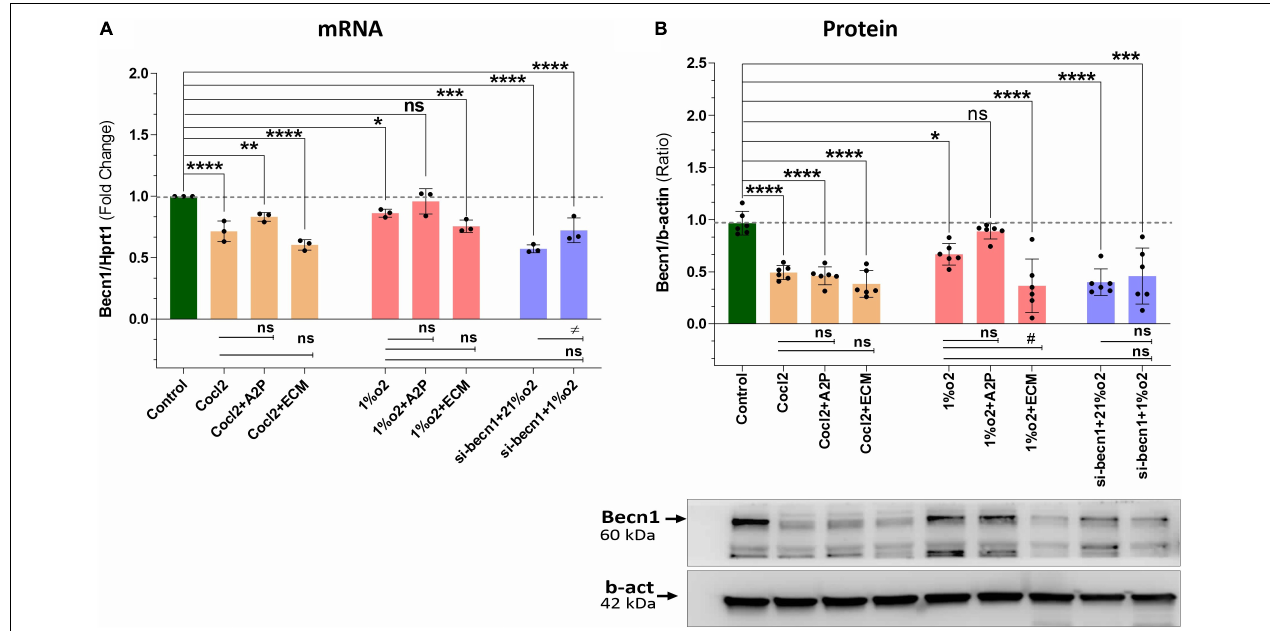
FIGURE 9 | Hypoxia, Cocl2 exposure decrease the Autophagy protein- Becn1 ( Beclin-1) expression at mRNA and Protein level. (A) Becn1 mRNA expression levels (B), Becn1 protein expression levels and representative western blots showing Becn1 protein levels in H9c2 cells treated with ECM, A2P, siRNA-Beclin1 and grown under CoCl2, Hypoxia (1%O2), and Normoxia conditions (21%O2). Becn1 mRNA levels was decreased in h9c2 cells exposed to Cocl2 (**** p < 0.0001), Cocl2 + ATP (** p < 0.004) and Cocl2 + ECM (**** p < 0.0001). Becn1 mRNA levels decreased in Hypoxia cells (1%O2) (* p < 0.019) and in Hypoxia (1%O2) + ECM, *** p < 0.0001. Beclin-1 inhibition decreased the becn1 mRNA levels in normoxia (21%O2) **** p < 0.0001 and in hypoxia (1%O2) (**** p < 0.0001) exposed cells. Becn1 protein expression levels also decreased in Cocl2 (**** p < 0.0001), Cocl2 + A2P (**** p < 0.0001), Cocl2 + ECM (**** p < 0.0001), and in Hypoxia (1%O2) * p < 0.026, and in 1%O2 + ECM (**** p < 0.0001). Beclin-1 inhibition confirms the decreased Becn1 protein under normoxia (21%O2) exposure (**** p < 0.0001) and in Hypoxia (*** p < 0.0003). Data represents, n = 3 (mRNA) and n = 6 (Protein) independent samples/group; Bars are mean ± S.D. Symbols * , + , # and (cid:54)= denotes significant, “ns” represents not significant by two-way ANOVA- multiple comparisons test. P-values are ns p > 0.05, * p < 0.05, ** p < 0.01, *** p < 0.001, and **** p < 0.0001 compared to Control; + p < 0.05, ++ p < 0.01, +++ p < 0.001, and ++++ p < 0.0001 compared to Cocl2; # p < 0.05, ## p < 0.01, ### p < 0.001, and #### p < 0.0001 compared to Hypoxia; (cid:54)= p < 0.05, (cid:54)= (cid:54)= p < 0.01, (cid:54)= (cid:54)= (cid:54)= p < 0.001, and (cid:54)= (cid:54)= (cid:54)= (cid:54)= p < 0.0001 compared to si-becn1 (21%O2) Vs, si-becn1 (1%O2). In western blots “ → ” represents a specific